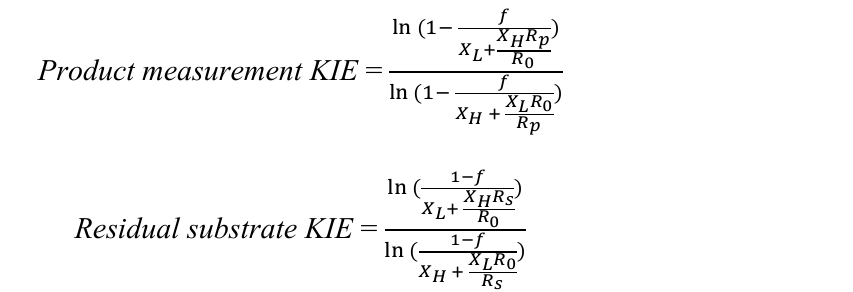
) and remaining substrate ( R p ) versus a function of fraction reaction f and at KIE 0